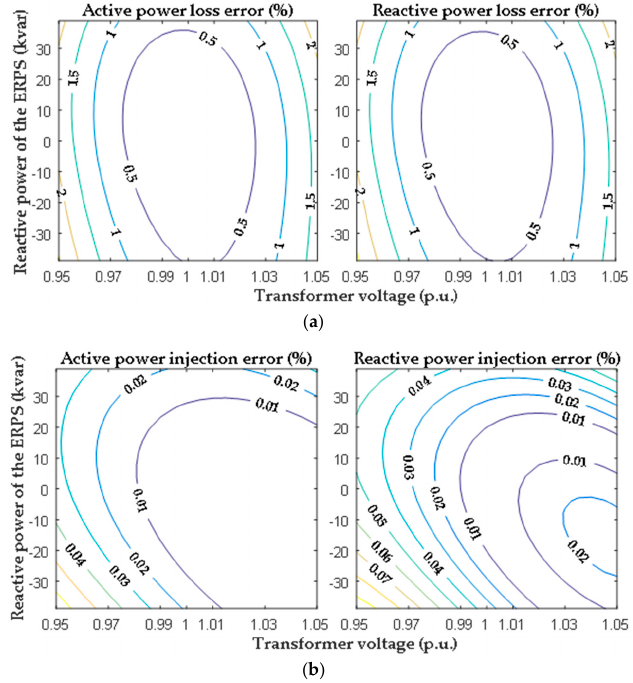
Figure 4. Error in the network power loss and residual power injection for low-voltage system 1. ( a ) Network power loss; ( b ) Residual power injection.